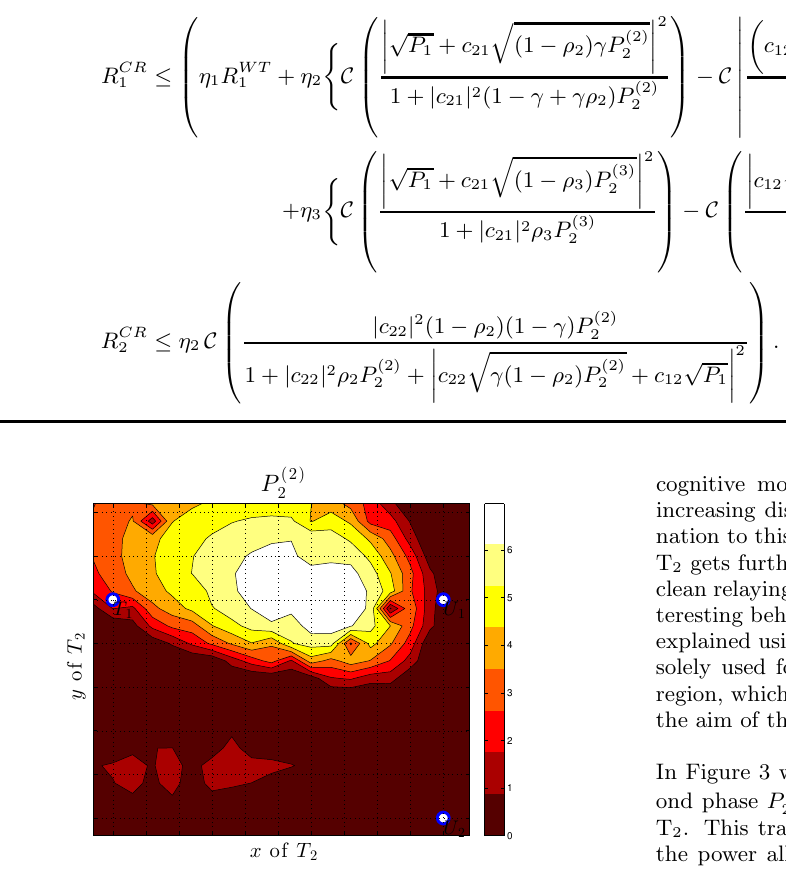
in the second 2